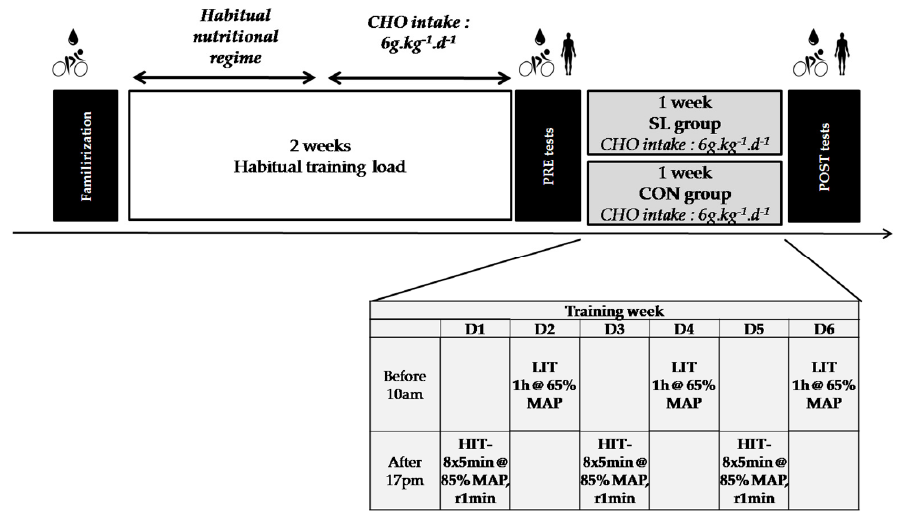
Figure 1. Overview of the experimental protocol; CHO: carbohydrates; HIT: high-intensity training session; LIT: light intensity training session; SL: Sleep-Low; CON: Control; MAP: Maximal aerobic power